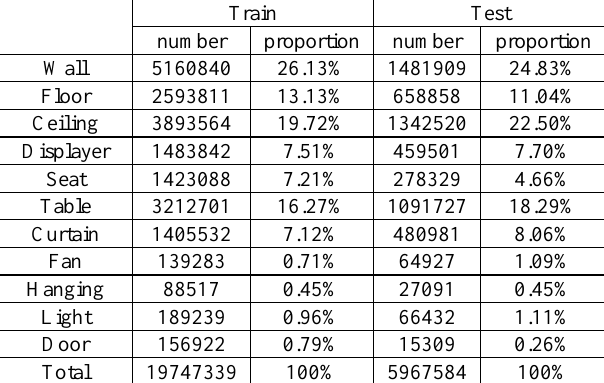
Table 1 numbers and proportion of each object in overall samples for training and